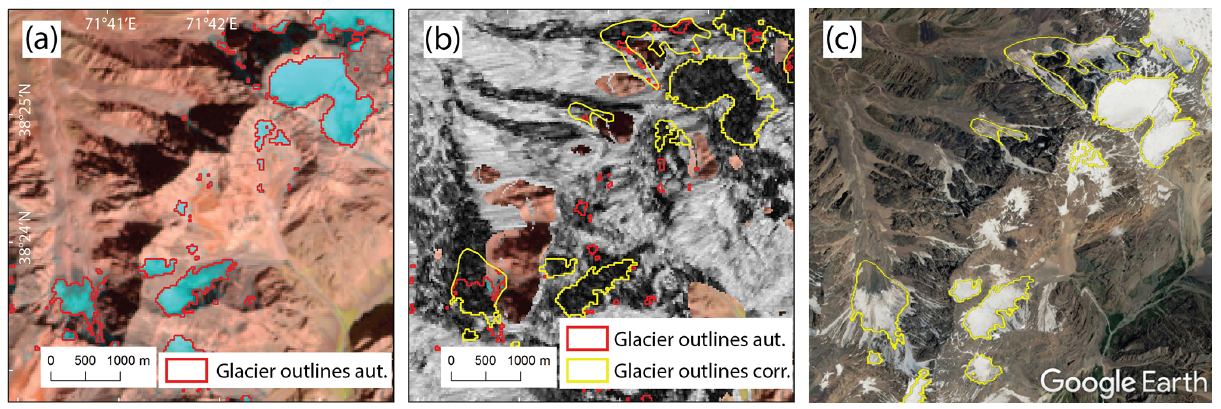
Figure 3. Elongated rock glaciers that are (almost) connected to the active glacier tongue are hard to distinguish. (a) False-colour Landsat image overlaid by raw outlines. (b) PALSAR-1 coherence images are fuzzy and potentially misleading in this case. (c) High-resolution imagery is decisive for a correct decision, because rock glaciers can be visually distinguished from the glacier